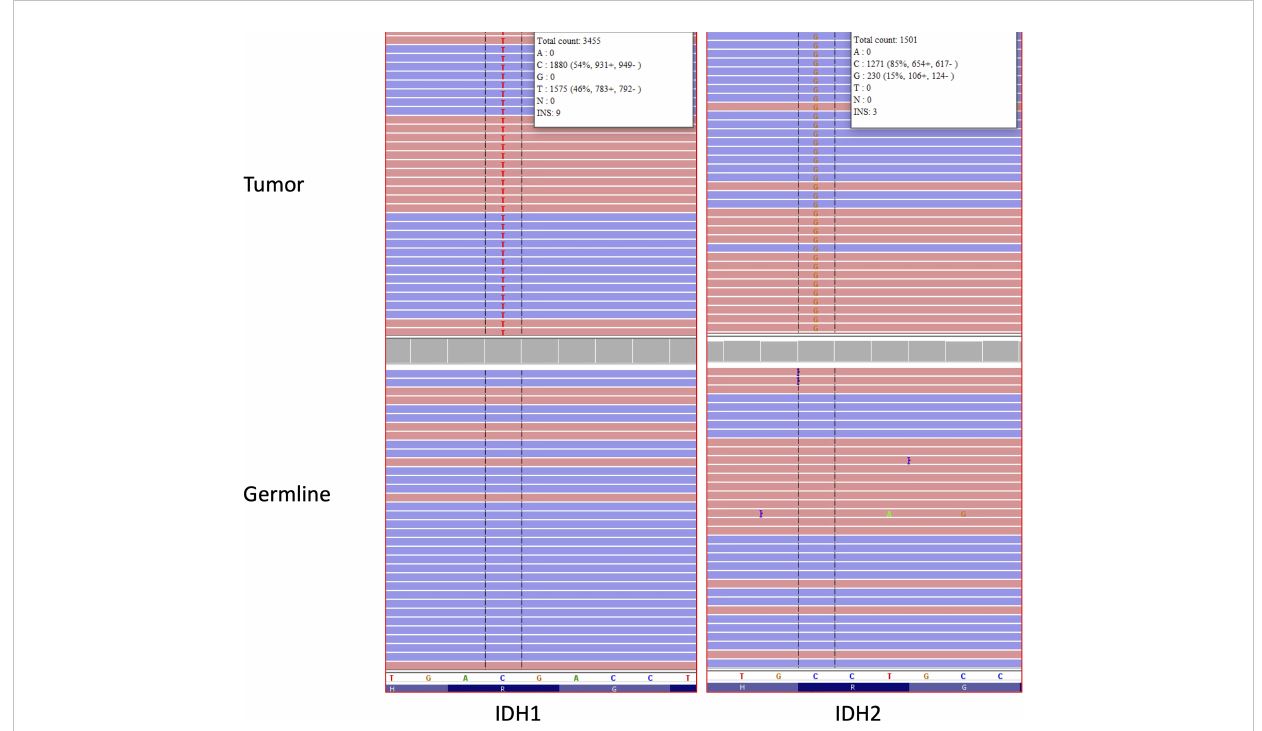
FIGURE 2 IGV traces showing somatic IDH1 p.R132H (C>T nucleotide change) and IDH2 p.R172S (C>G nucleotide change) mutations in the brain tumor tissue analyzed by NGS (Top). No IDH1 or IDH2 mutations were detected in DNA obtained from normal cells as a germline control (bottom). Red and blue bars represent forward and reverse sequencing reads, respectively. The reference nucleotide sequence for the depicted region of IDH1 and IDH2 is shown in the white bar in the lower portion of the fi gure. The “ H ” , “ R ” and “ G ” letters at the bottom of the fi gure represent the corresponding reference amino acid sequence for IDH1 and IDH2 (H = histidine, R= arginine, G=glycine).